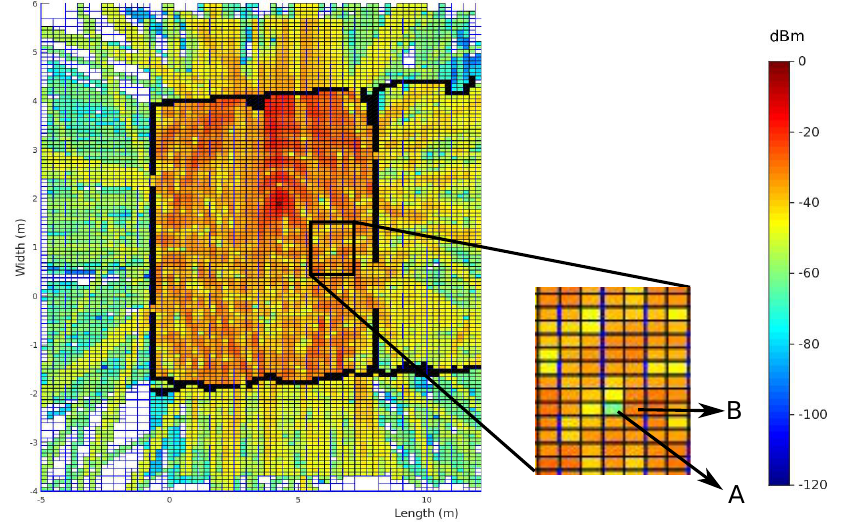
Figure 17. Local constructive and destructive